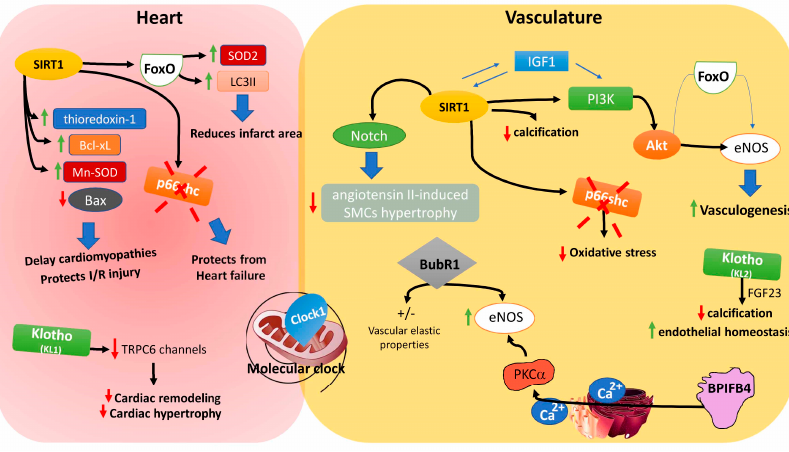
Figure 2. Schematic of the main genes involved in aging regulation and their related molecular mechanisms in heart and vasculature. The green arrows indicate the increase in production/expression; the red arrows indicate the decrease in production/expression.